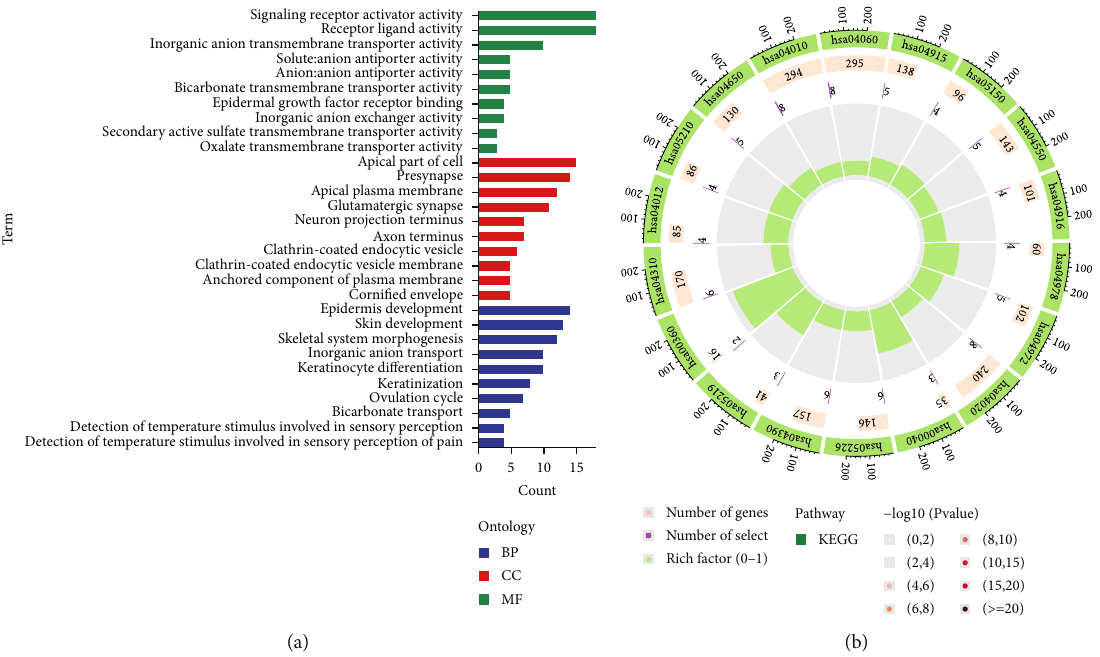
Figure 5: The enrichment analyses. (a) The GO analyses results. (b) The KEGG analysis